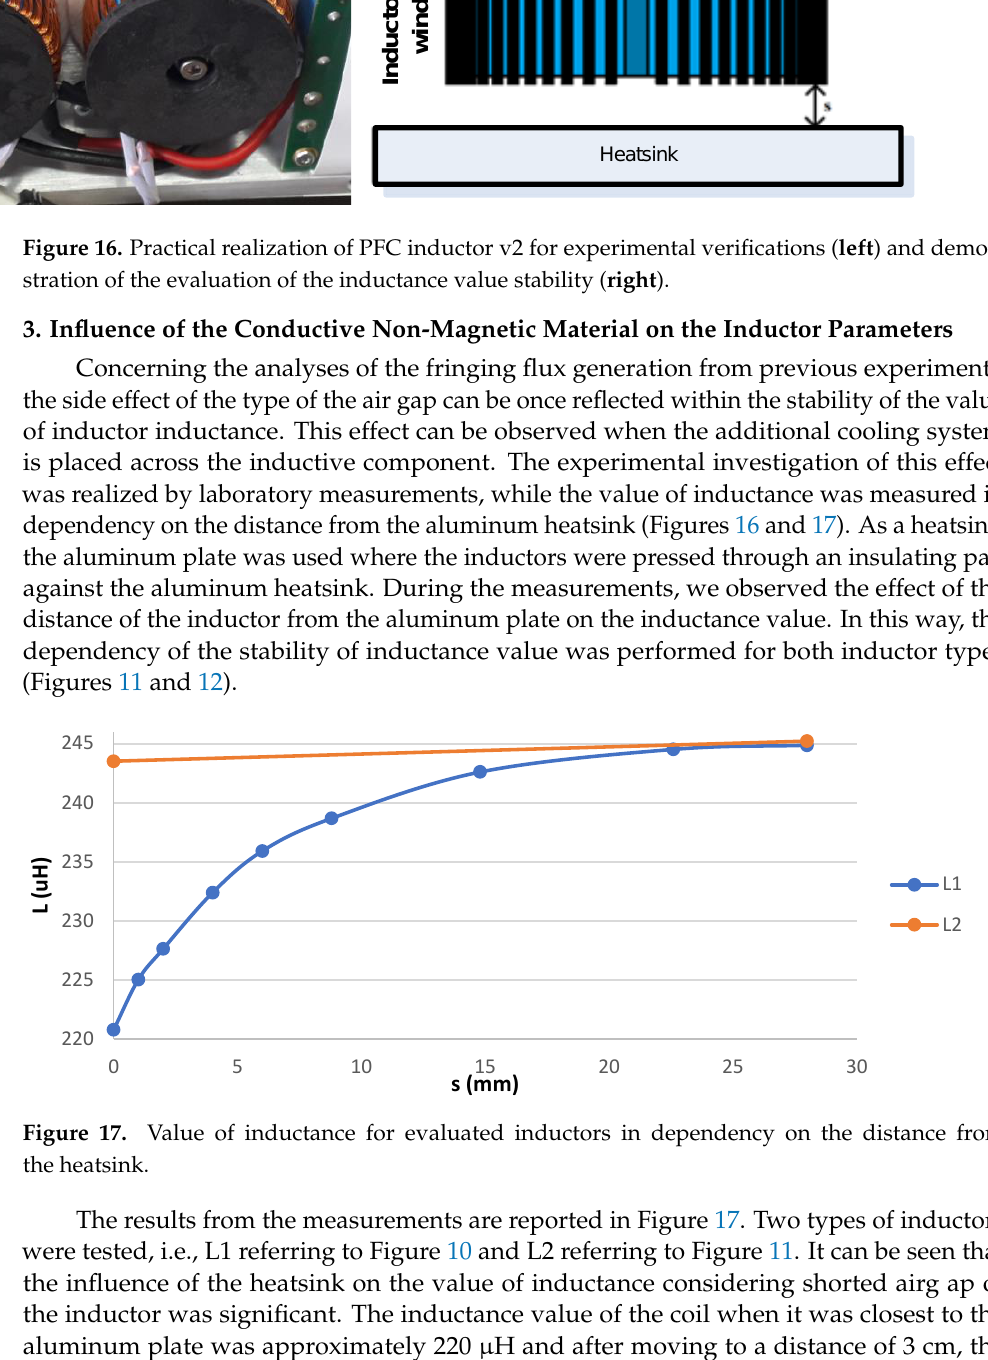
Figure 17. Value of inductance for evaluated inductors in dependency on the distance from the heatsink.